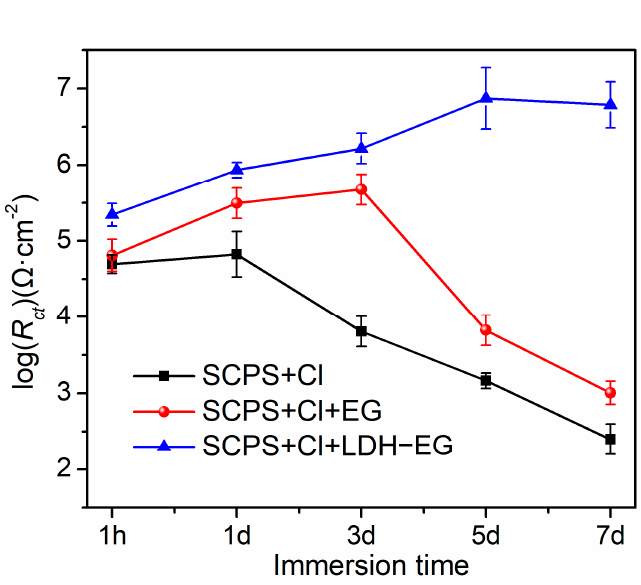
Figure 8. Equivalent electric circuits used for modeling the EIS results of Figure 7.